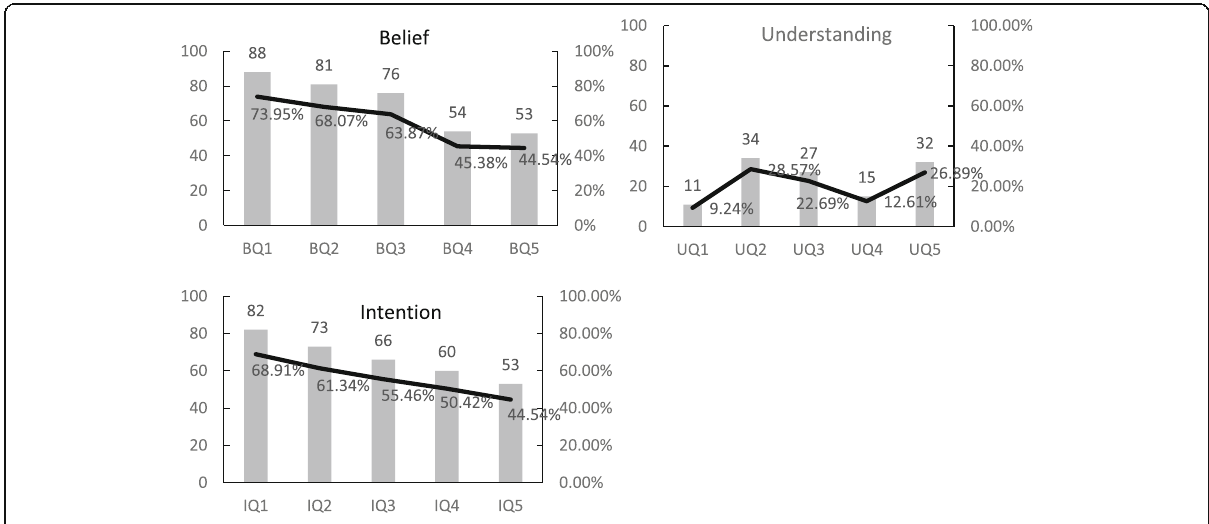
Fig. 6 Overall model of STEM among future teachers ’ platform towards capacity building regarding